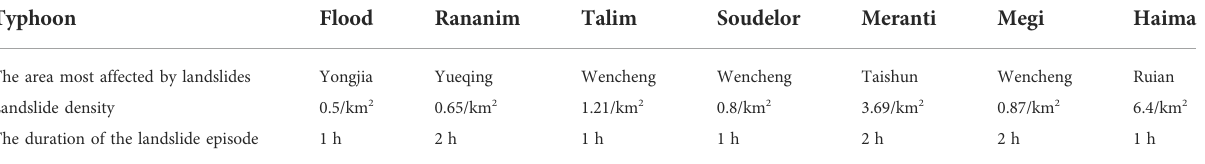
TABLE 1 Statistics on density and duration of typhoon-triggered landslides in the region.